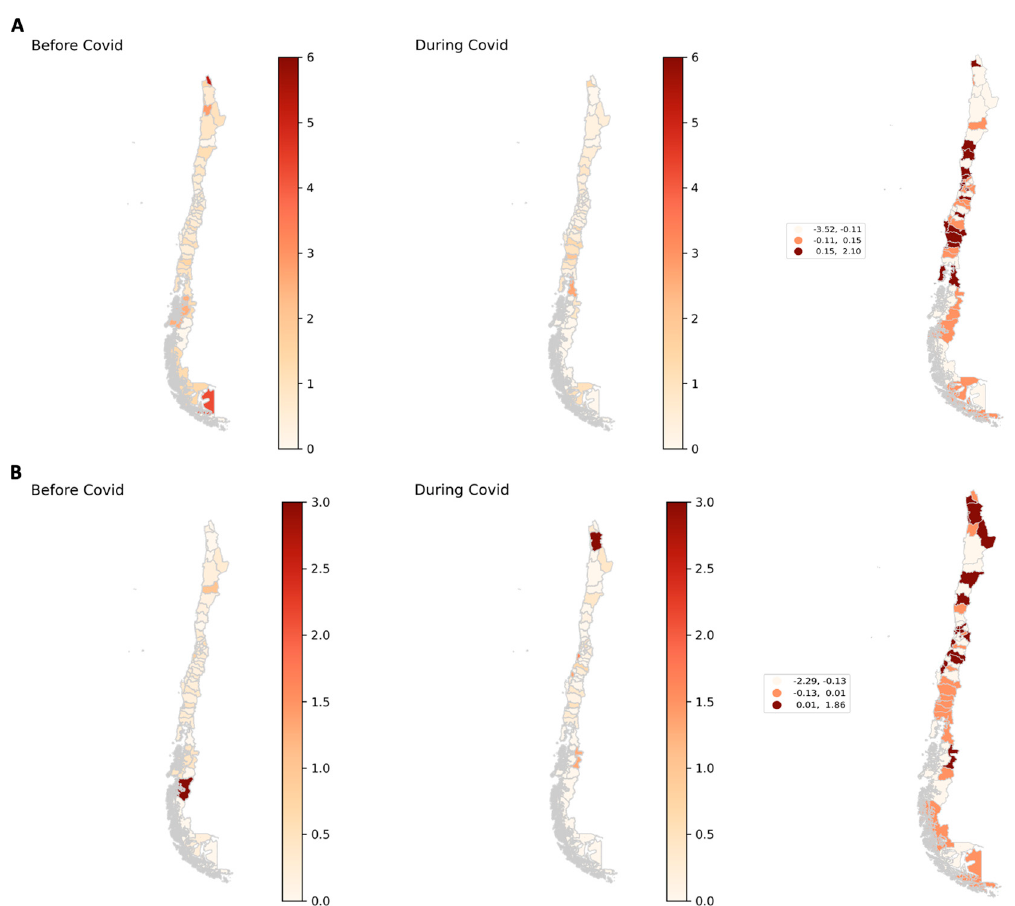
Figure 2. Distributions of the attempted-femicide and femicide rates before and during COVID- 19 in Chile. ( A ) Mean quarterly attempted-femicide rate per 100,000 women before and during COVID-19 and tertile map of the differences in each province. ( B ) Mean quarterly femicide rate per 100,000 women before and during COVID-19 and tertile map of the differences in each province.